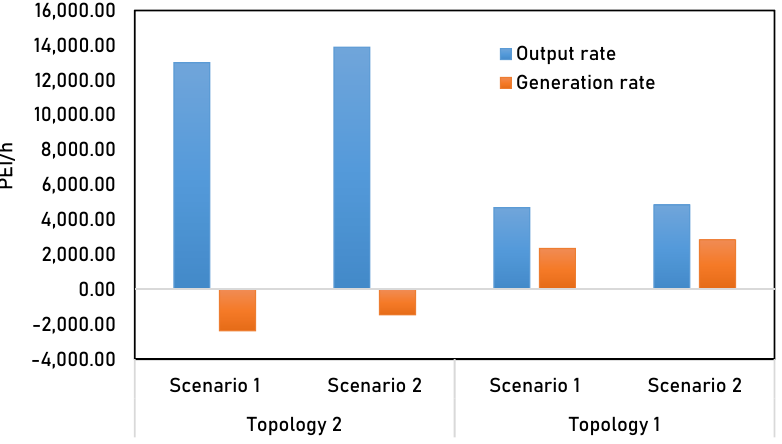
Figure 12. Overall output and generation rates (time basis) for evaluated topologies.